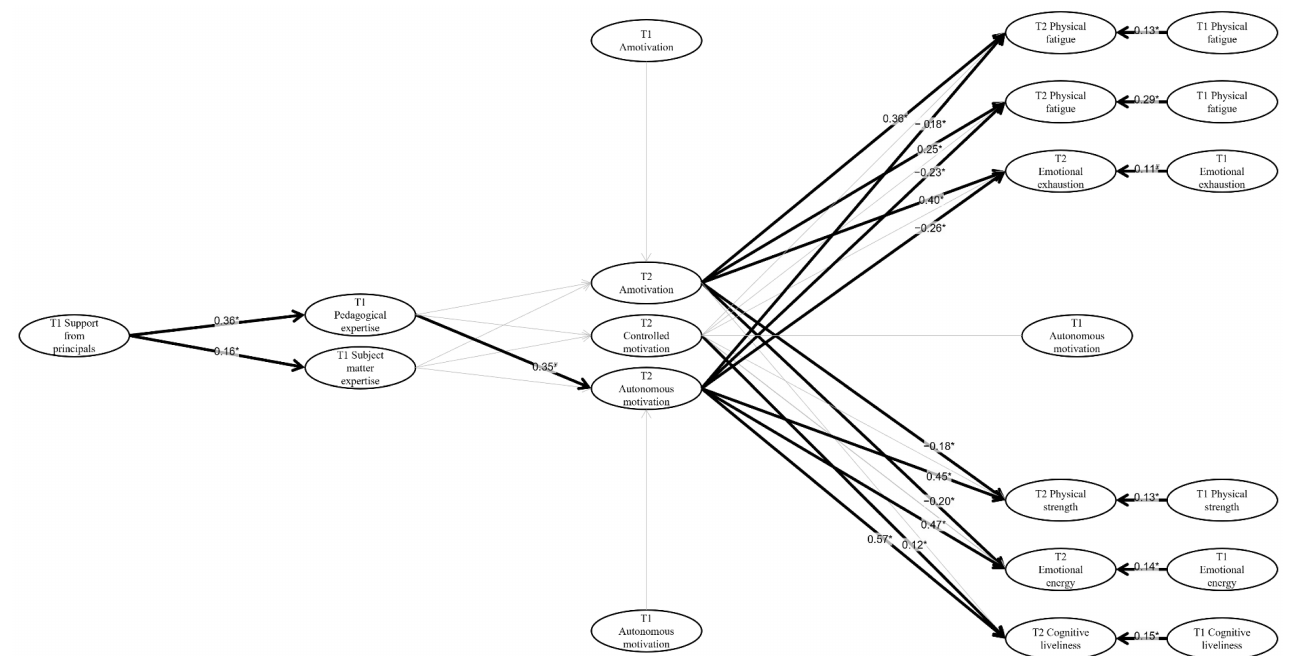
Figure 1. Significant relationships between the study variables. Note. * p < 0.05; ¥ p < 0.10. The scores of the three dimensions of T2 burnout were positively and significantly related to T2 amotivation ( β = 0.64, p < 0.01 for physical fatigue, β = 0.39, p < 0.01 for cognitive weariness, and β = 0.40, p < 0.01 for emotional exhaustion) and negatively related to T2 autonomous motivation ( β = − 0.27, p < 0.05 for physical fatigue, β = − 0.30, p < 0.01 for cognitive weariness, and β = − 0.21, p < 0.01 for emotional exhaustion). In contrast, the scores of T2 vigour were negatively and significantly related to T2 amotivation ( β = − 0.27, p < 0.05 for physical strength, and β = − 0.27, p < 0.05 for emotional energy) and positively by T2 autonomous motivation ( β = 0.56, p < 0.01 for physical strength, β = 0.62, p < 0.01 for cognitive liveliness, and β = 0.53, p < 0.01 for emotional energy). In addition, T2 cognitive weariness was marginally significantly and positively predicted by T2 controlled motivation ( β = 0.09, p =